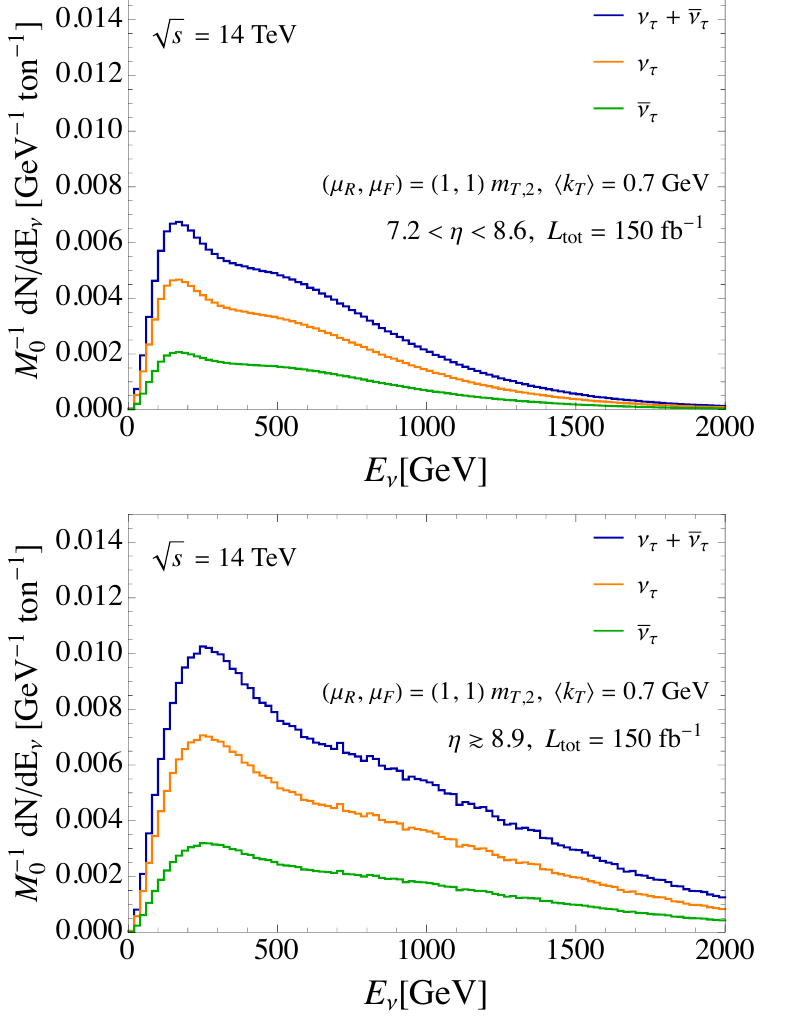
Figure 17. The energy distribution of the number of tau neutrino and antineutrino charged- current events per neutrino energy per 1 ton of detector a distance D d = 480 m from the collider interaction region for the pseudorapidity ranges of 7 . 2 . η . 8 . 6 (upper) and η & 8 . 9 (lower) for √ the neutrinos produced in pp collisions at s = 14